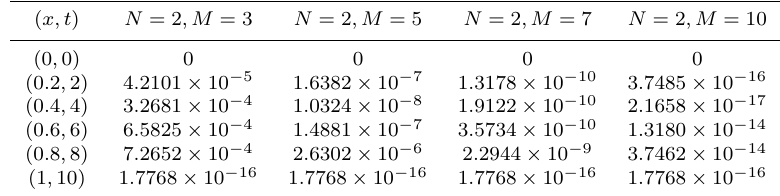
Table 3. Absolute error for different values of M with β = 1 and ν = 2 on the interval [0 , 1] × [0 , 10] for Example 4. ( x,t ) N = 2 ,M = 3 N = 2 ,M =